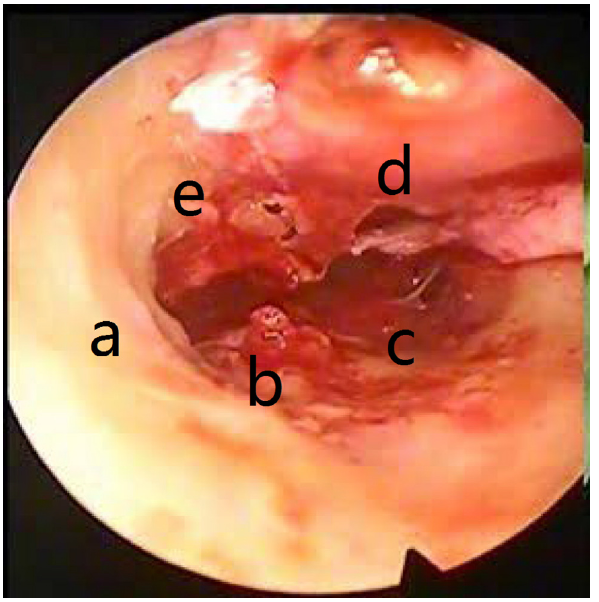
Fig 5. Postoperative middle ear microscopic view after the atticotomy and cholestetoma removal. (a) Scutum after the atticotomy; (b) Stapes capitalum; (c) Hypotympanic air cells; (d) Tympanic; (e) Membrane